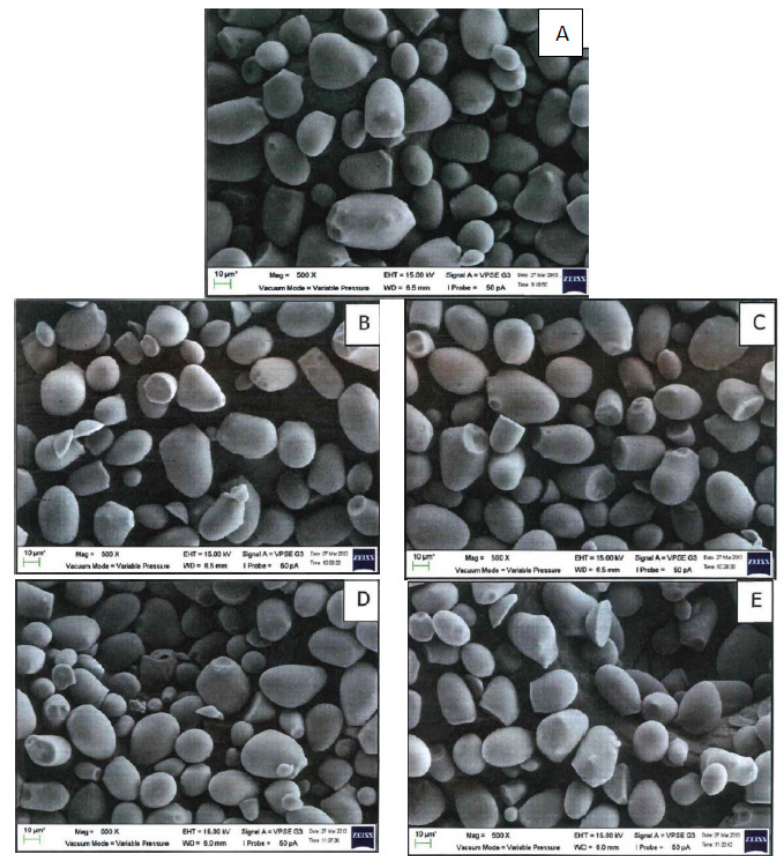
Figure 1. Scanning electron micrographs of ( A ) native sago; ( B ) 5 kGy; ( C ) 10 kGy; ( D ) 25 kGy; ( E ) 50 kGy (500× magnification). Dent surfaces and the development of pores on the starch granules (indicated by the arrows) are found on the ANN(T o -5) and the ANN(T o -10), as depicted in Figure 2. Xu et al. [47] reported most of the potato starch granules retained their original appearance, whereby only a small number of starch granules appeared with grooves and dents on their granule surfaces after annealing. Rocha et al. [48] found an increase of the pores on the surface of the granules for both the normal and waxy con starches and attributed this to the hydrolysis activity of the endogenous amylase under the annealing condition. No pronounced change occurred in the granule morphology when ANN was applied to green banana flour [49]. Waduge et al. [50] found that annealed starch exhibited increased gran- ular size due to the ingress of moisture through the amorphous regions of the starch dur- ing annealing, which was not seen in this study.